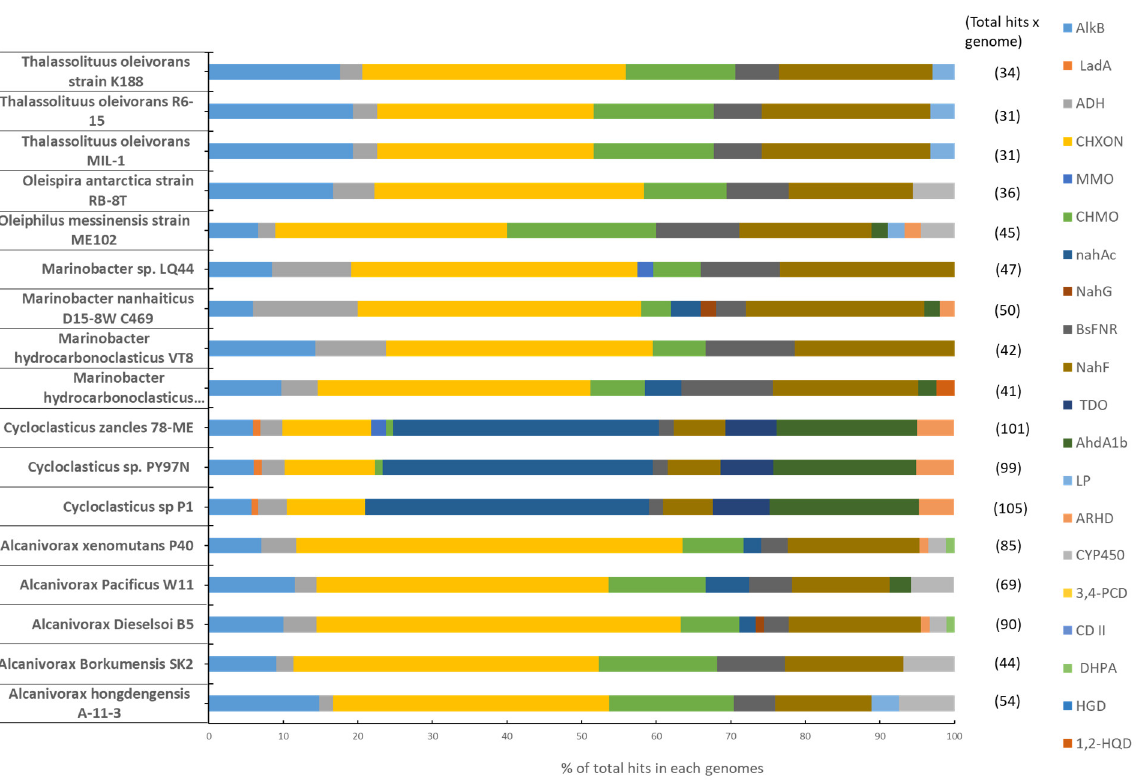
Figure 3. Relative abundance (expressed as % of the total hits) of genes involved in the degradation of aliphatic and aromatic hydrocarbons within the genomes of hydrocarbonoclastic bacteria. For each bacterial genome, the relative abundance of a single query gene has been calculated as the ratio between the number of genomic hits to that specific query gene, and the total number of genomic hits to all the 20 query genes involved in hydrocarbon degradation. The analysis was conducted using the standalone version of BLAST (Bit-Score > 80; e-Value < 0 e-15; [190]) to document the presence of the genes of interest within the selected genomes. The legend on the right refers, from top to bottom, to (AlkB) alkane hydroxylase, (LadA) alkane monooxygenase LadA, (ADH) alcohol dehydrogenase, (CHXON) cyclohexanol dehydrogenase, (MMO) methane monooxygenase, (CHMO) cyclohexanone monooxygenase, (nahAc) naphthalene dioxygenase, (NahG) salicylate 1-monooxygenase, (BsFNR) ferrodoxin reductase, (NahF) salicylaldehyde dehydrogenase, (TDO) toluene dioxygenase, (AhdA1b) ethylbenzene dioxygenase large subunit, (LP) lipase, (ARHD) aromatic ring-hydroxylating dioxygenase subunit alpha, (CYP450) cytochrome P450, (3,4-PCD) protocatechuate 3,4-dioxygenase, (CD II) catechol 1,2 dioxygenase, (DHPA) 3,4-dihydroxyphenylacetate 2,3-dioxygenase, (HGD) homogentisate 1,2-dioxygenase and (1,2- HQD) hydroxyquinol 1,2-dioxygenase.